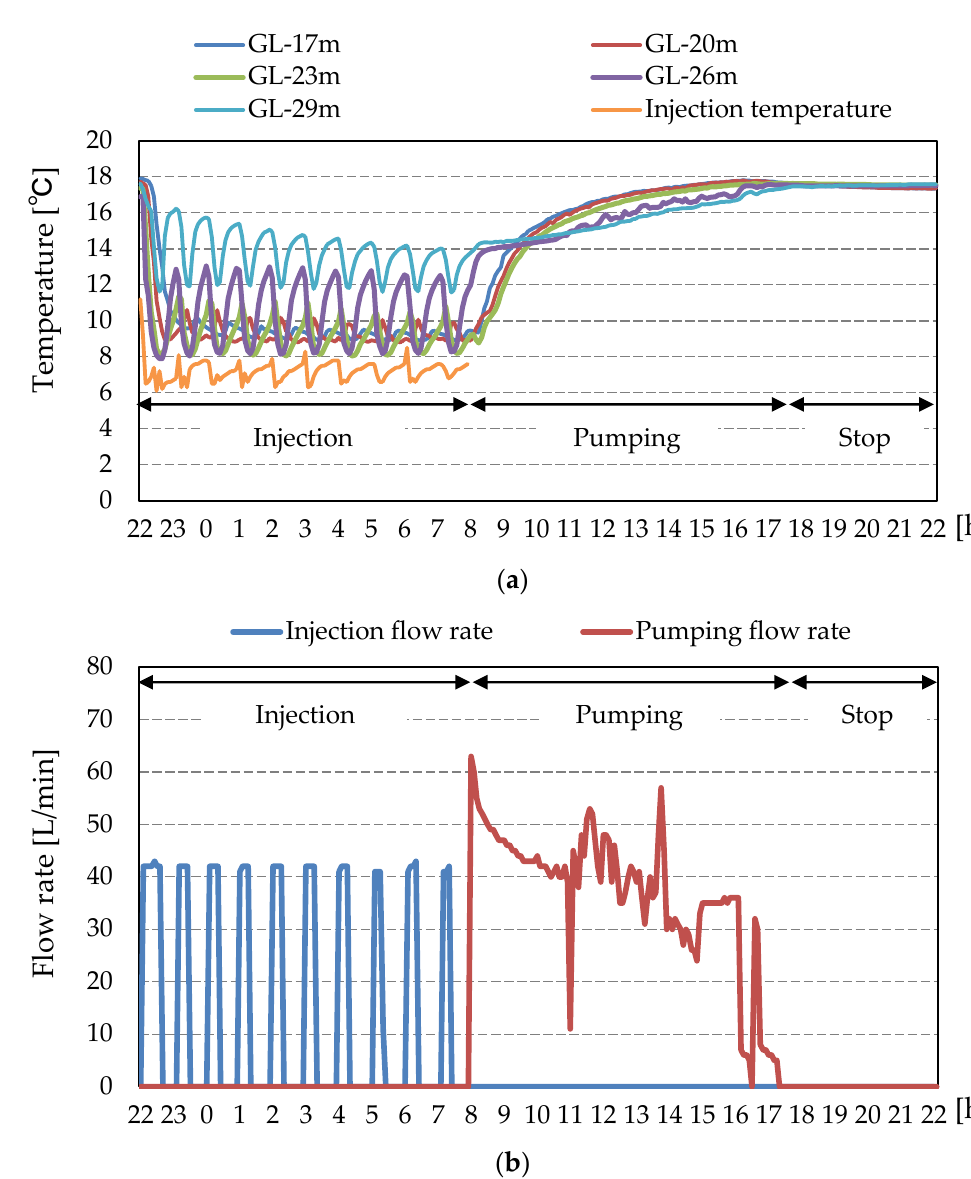
Figure 4. The experimental data of the ATES system: ( a ) The temperature response inside the heat reservoir well; ( b ) The water injection and pumps flow rate in the heat reservoir.